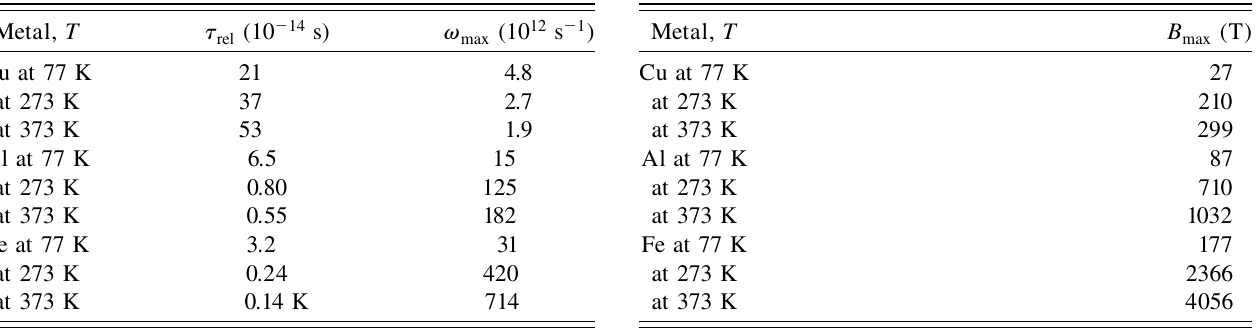
TABLE I. Relaxation times [11] and implied frequency lim- its due to the onset of ac conductivity for three metals and temperatures.